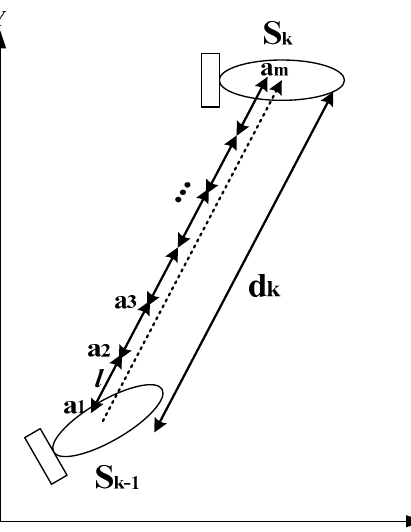
Figure 7. Online estimation of measured noise.